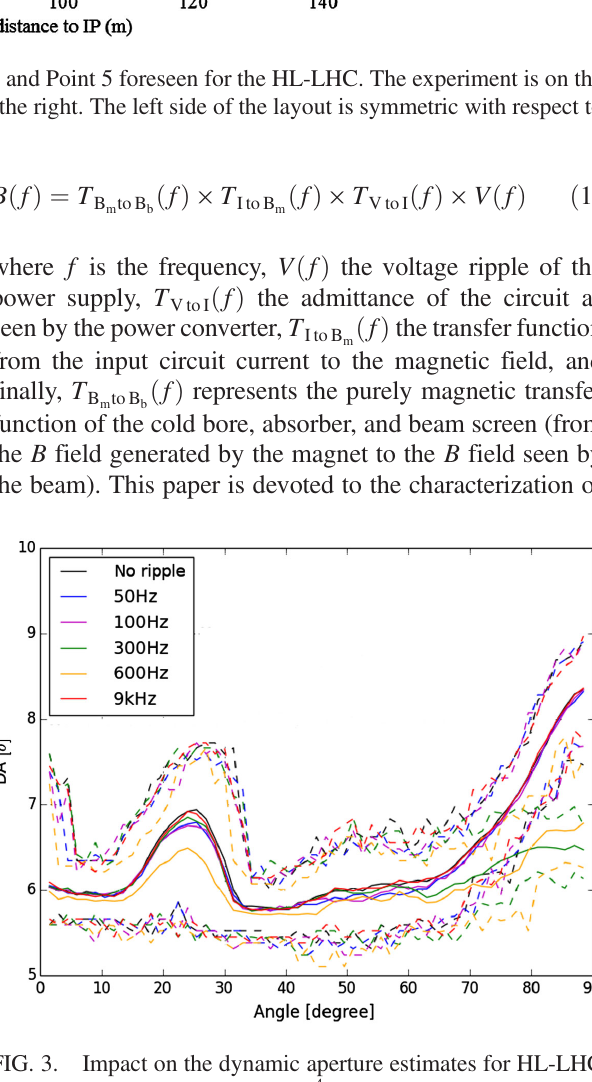
FIG. 3. Impact on the dynamic aperture estimates for HL-LHC of a tune ripple source giving 10 − 4 perturbation as a function of ripple frequency. The dynamic aperture is estimated by determin- ing the first initial transverse normalized amplitude for a given azimuthal angle of particles that are lost after 10 5 turns. The calculation is performed on 60 HL-LHC machine models with a statistical distribution of magnetic field imperfections compatible with the magnetic measurements. The plot shows the average dynamic aperture (continuous lines) and the minimum and maximum dynamic aperture (dashed lines) over the 60 machine models as a function of the azimuthal angle of the initial conditions for different noise frequencies. Tune fluctuations at 300 and 600 Hz result in dynamic aperture reductions and justify a detailed analysis of how noise sources in this frequency range can propagate inside the vacuum